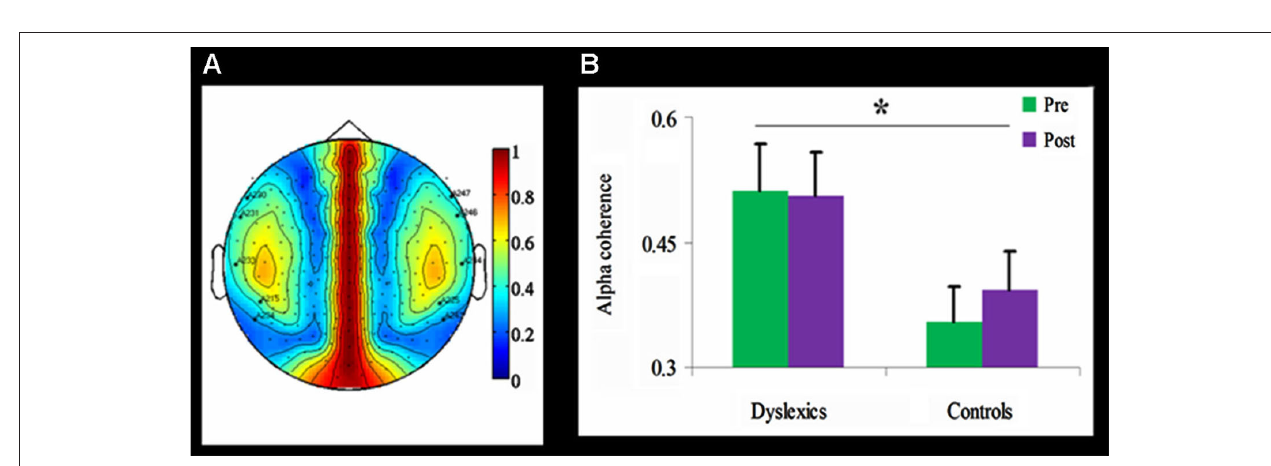
0.0025 in addition to a cluster size threshold of 20 voxels. The focus point (green cross) is positioned in the right culmen (Talairach coordinate: 12, − 37, − 22). (C) The bar graph shows alpha power as a function of Group and Training (mean + SEM). * p = 0.01; ** p = 0.001.